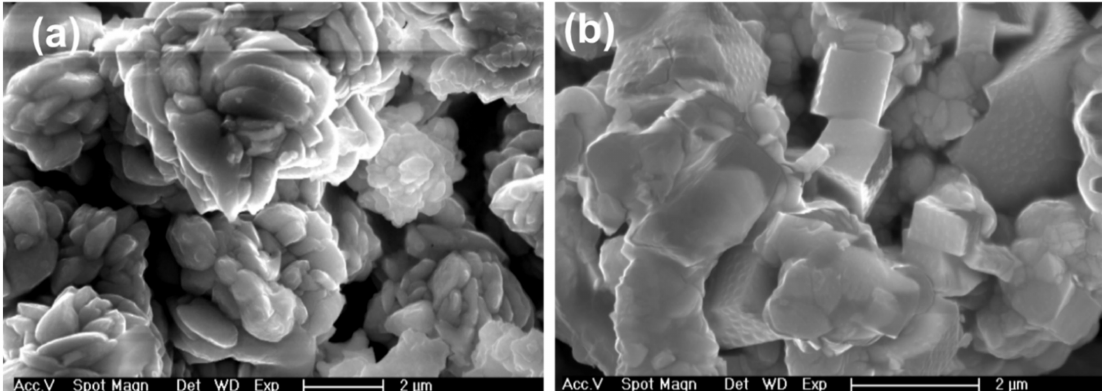
Figure 3. SEM micrographs of PbSe prepared at: ( a ) 400 ◦ C ( b ) 450 ◦ C.